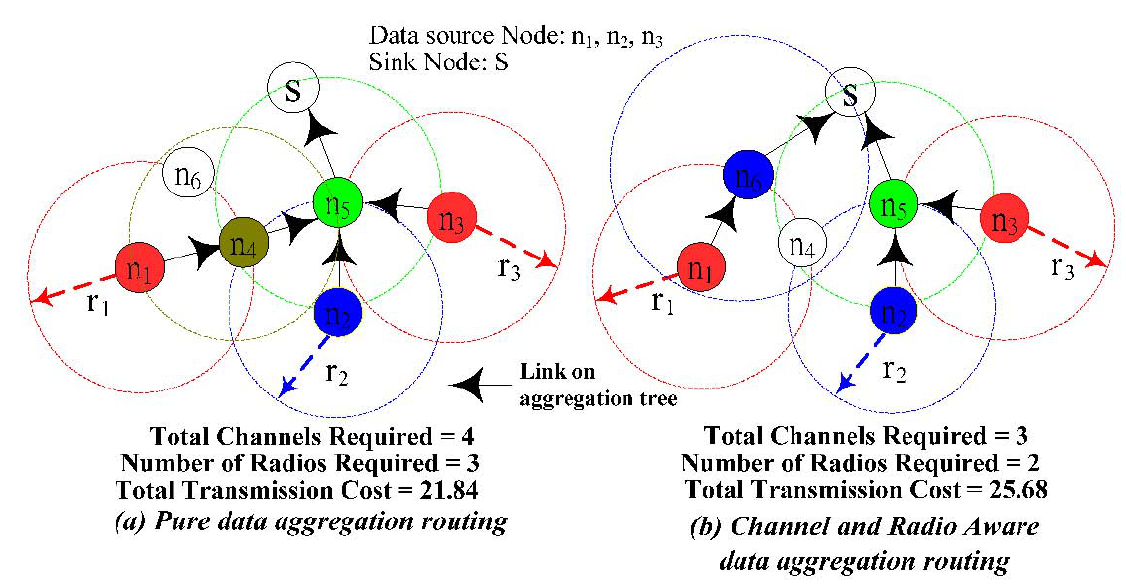
Figure 3. Channel, radio and rata aggregation